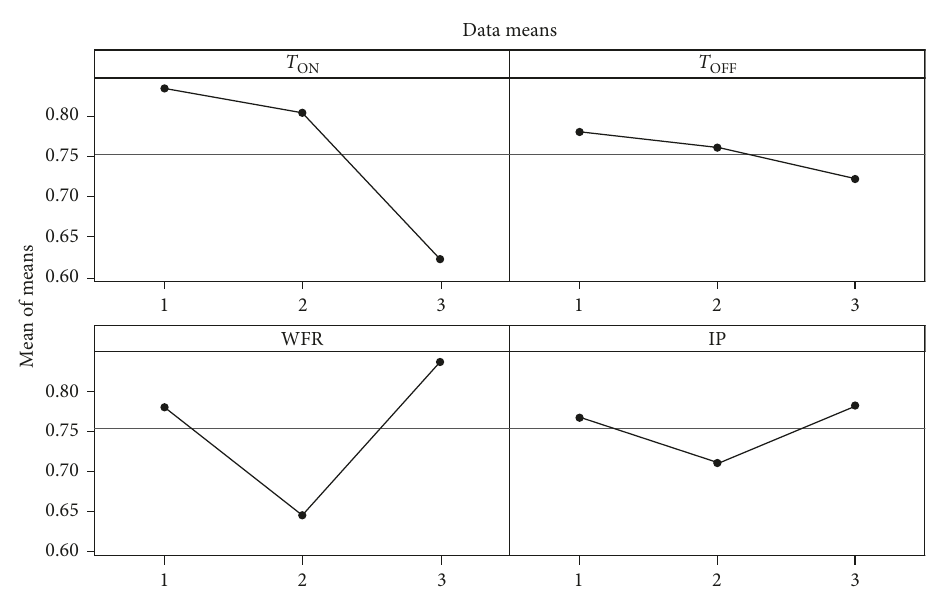
Figure 12: Main effects plot for GFRG.